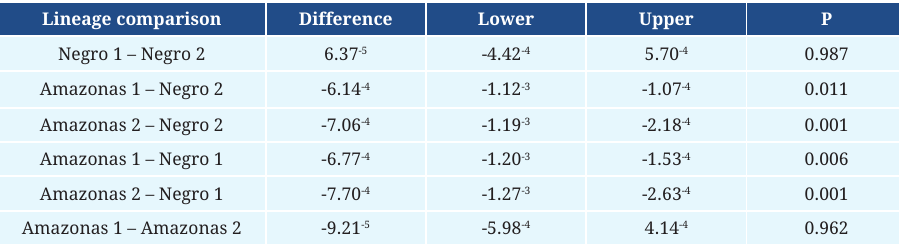
TABLE 1 | Results of Tukey’s HSD test showing all between-population comparisons of color change rate